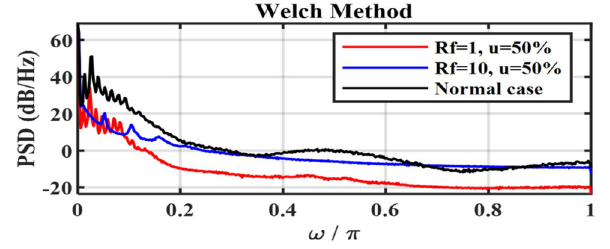
Fig. 3 The current’s PSD estimation based on WELCH at different operating conditions